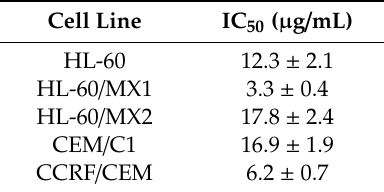
Table 3. The extrapolated IC 50 values for the various leukemic cell